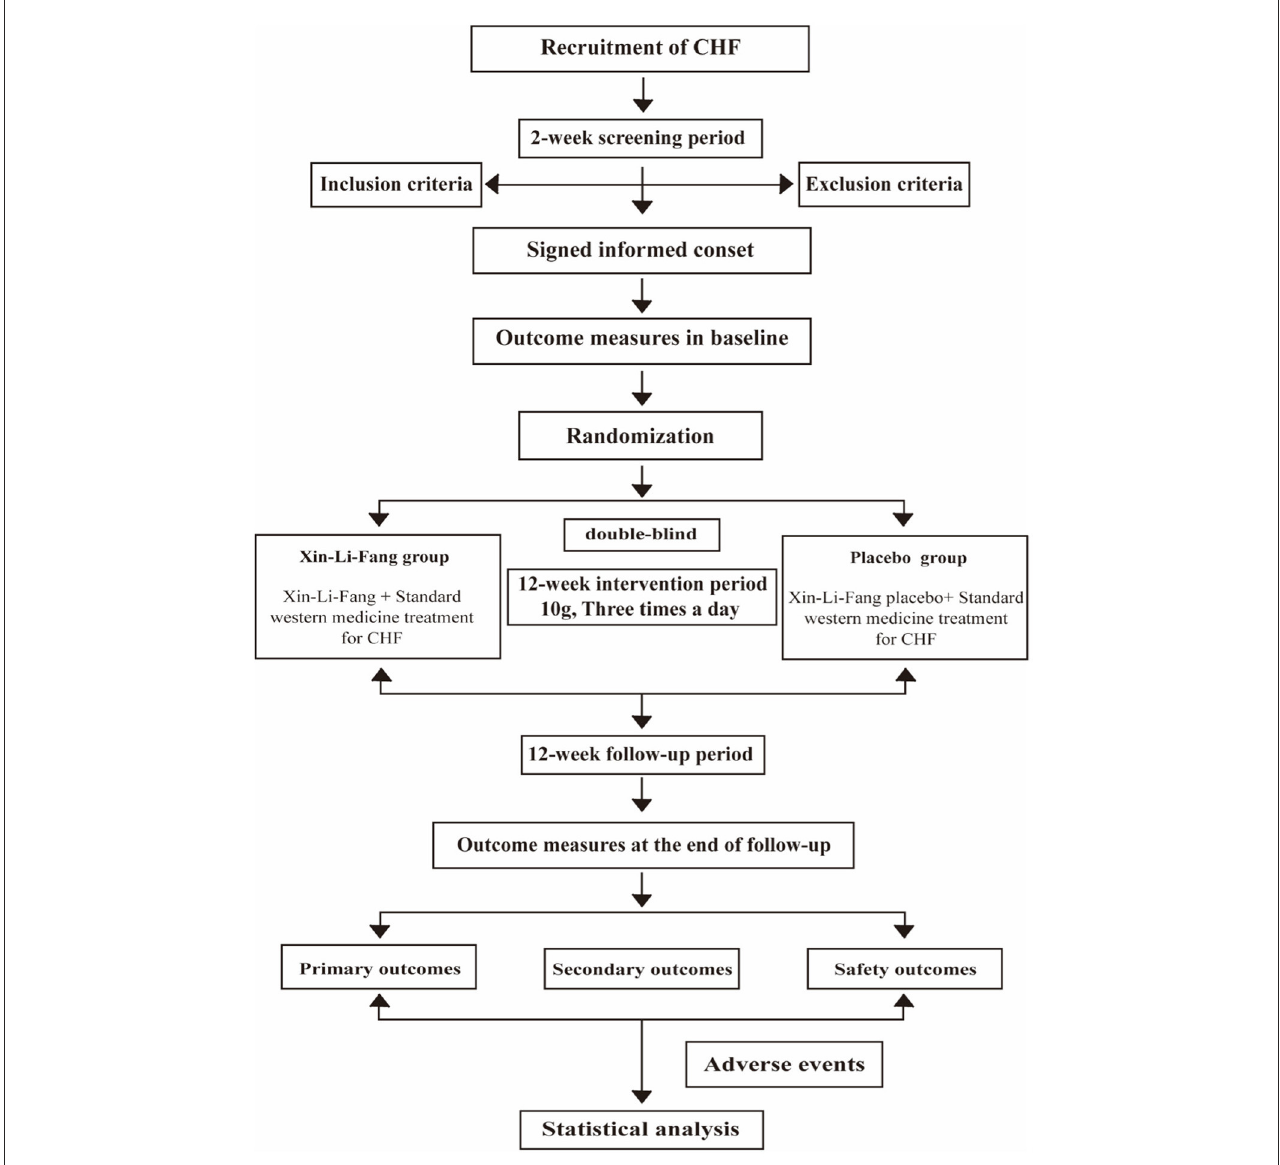
FIGURE1 Study flowchart. CHF, chronic heart